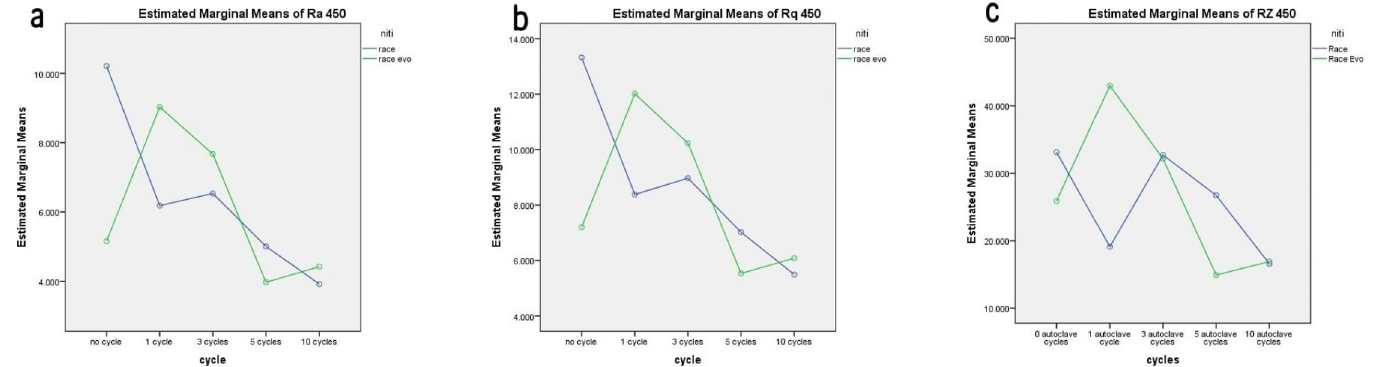
Fig 2. Changes in surface roughness values at 450x magnification according to NiTi file and number of autoclave cycles a) Ra, b) Rq, and c) Rz.